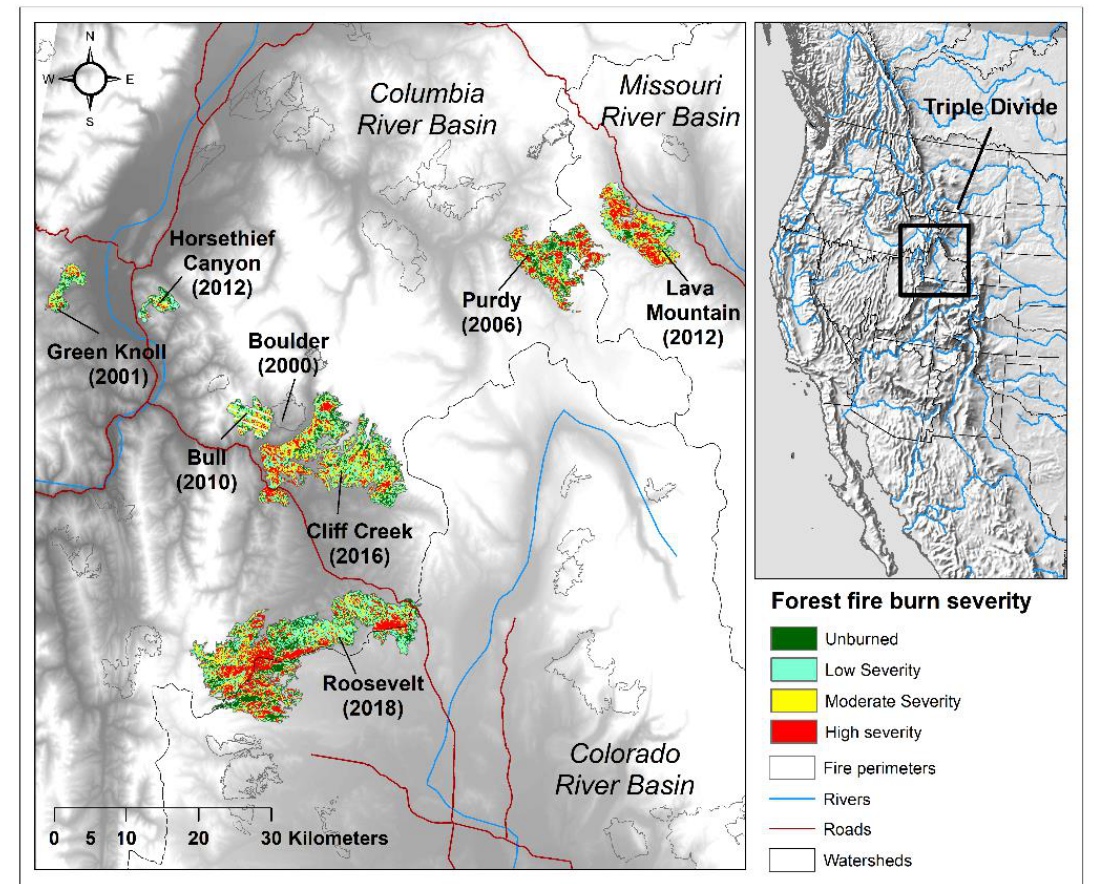
Figure 2. Post-fire landscape snow albedo recovery was evaluated across a chronosequence of eight burned forests in the Triple Divide region of western Wyoming, the headwaters of the Columbia, Colorado, and Missouri River Basins. Table 1. Characteristics of eight forest fire sites used in this